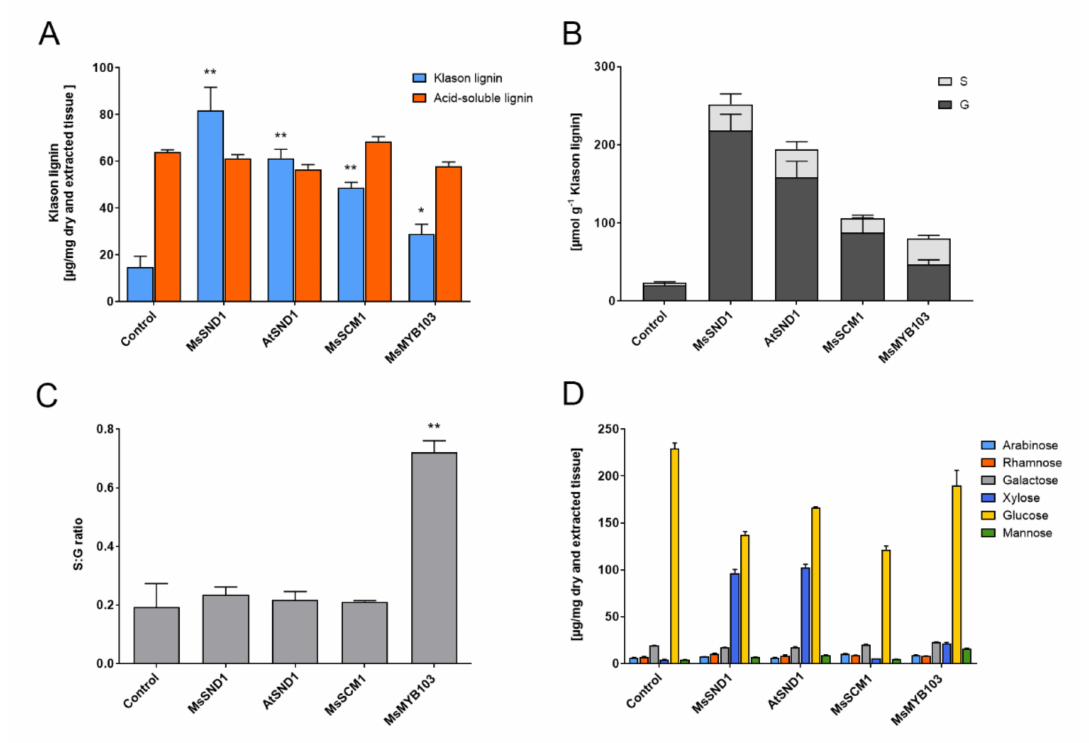
Figure 3. Change in cell wall composition induced by ectopic expression of MsSND1, MsSCM1, and MsMYB103 in N. benthamiana leaves. ( A ) Lignin content was determined by Klason analysis (acid-insoluble lignin) and by OD 205 (acid- soluble lignin); ( B , C ) ratio of syringyl and guaiacyl monomer release from thioacidolysis products detected by gas- chromatography; ( C , D ) structural carbohydrate compositions of insoluble extracts were determined by high-pressure liquid chromatography (HPLC), as µ g/mg of dry cell walls. As a control, an empty vector construct was infiltrated in N. benthamiana leaves. The bars represent mean values from two ( B , C ) or three ( A , D ) biological replicates + SE including two technical replicates for ( A , D ). Asterisks in ( A , C ) indicate statistically significant difference with p < 0.05 (*) or p < 0.01 (**) according to Mann-Whitney U